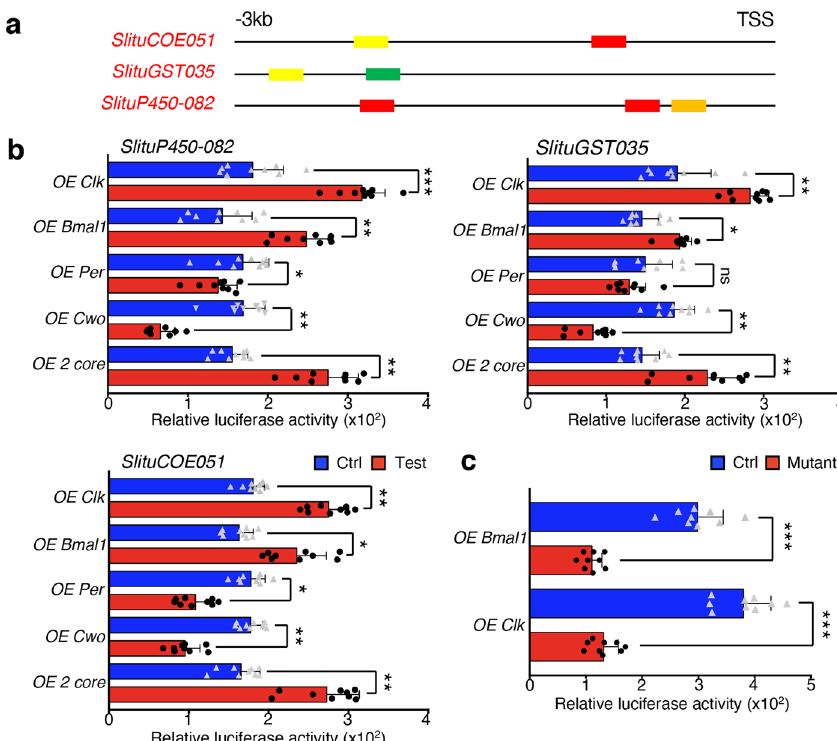
Fig. 6 Effects of core circadian gene overexpression on detoxi fi cation gene transcription through E-box binding in cultured cells. a Location of canonical (CACGTG, red) and non-canonical (CACCTG, yellow; CATGTG, green; CAACTG, orange) E-boxes in 5 ′ regulatory regions of SlituCOE051 , SlituGST035 , and SlituP450-082 . b Relative luciferase activity for the promoters of SlituP450-082 , SlituGST035 , and SlituCOE051 induced by co-transfection of Spli-221 cells with SlituClk ( OE Clk ), SlituBmal1 ( OE Bmal1 ), SlituPer ( OE Per ), SlituCwo ( OE Cwo ), and combined SlituClk + Bmal1 ( OE 2 core ) overexpression vectors (red). Control vectors overexpress EGFP (blue). c Relative luciferase activity of mutated (TGTACT, red) and normal (CACGTG, Ctrl, blue) E-box sequences for SlituP450-082 induced by co-transfection of SlituClk and SlituBmal1 . The results are given as mean ± SEM of three repeated experiments and statistically